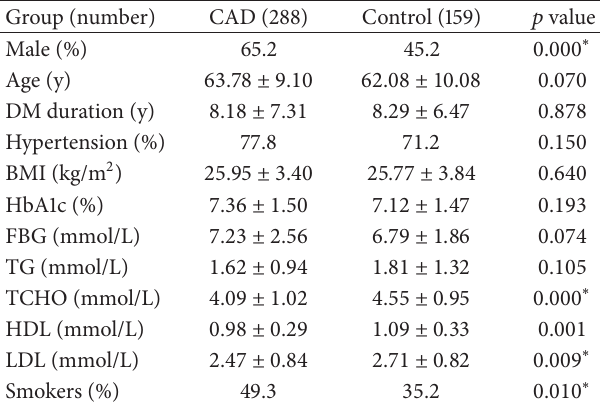
Table 1: Characteristics of study